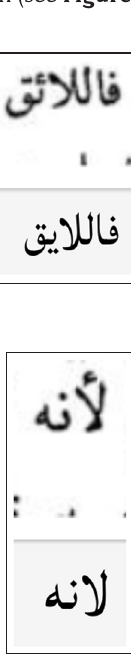
Figure 19: Missed hamza on